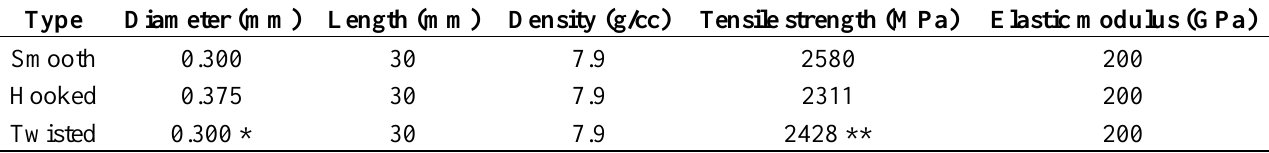
Table 2. Properties of fibers.